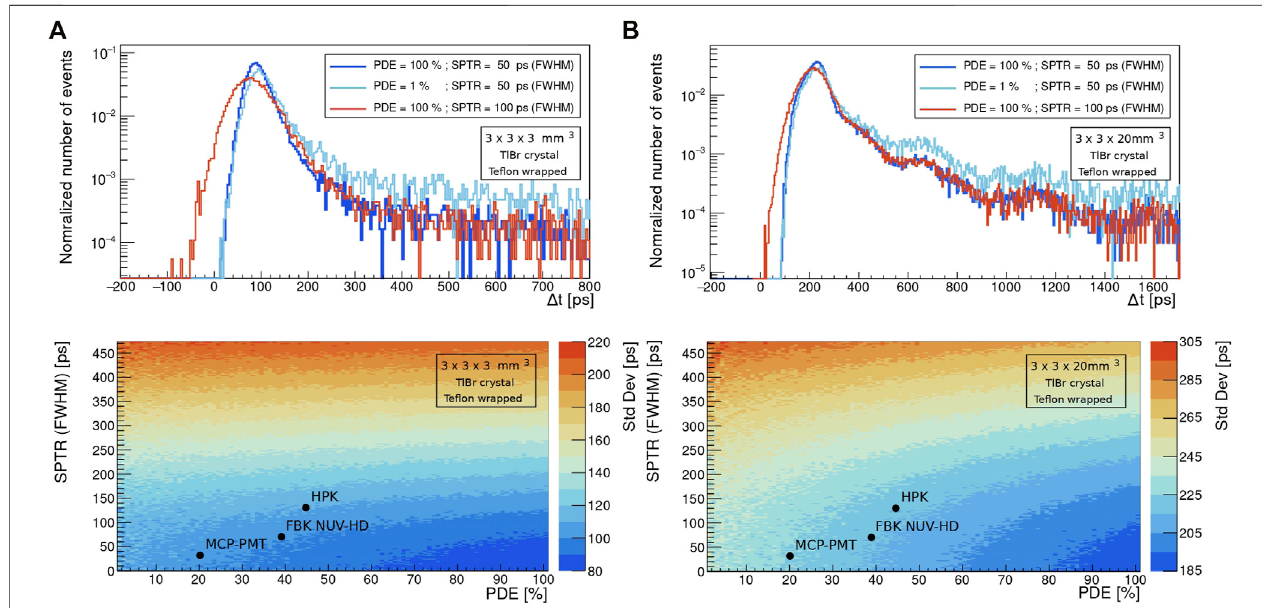
FIGURE9| (Top)Simulated time delaydistributionsconsidering three speci fi c[PDE(%),SPTR(FWHM)(ps)] pairs: (100, 50), (1, 50),and (100, 100), for (A) a3 mm and (B) 20 mmlongcrystal.(Bottom)StandarddeviationofthesimulatedoutputtimedistributionsasafunctionofthePDEandSPTRforthetwodifferentcrystallengths, (A) 3 mm and (B) 20